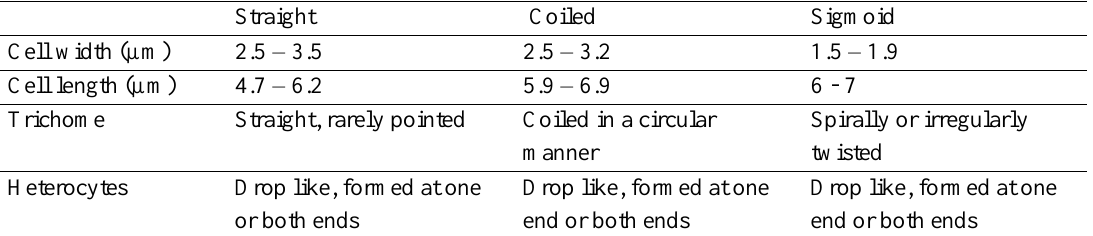
Table 4 : Main Characteristics of the three observed morphological forms of C. raciborskii.